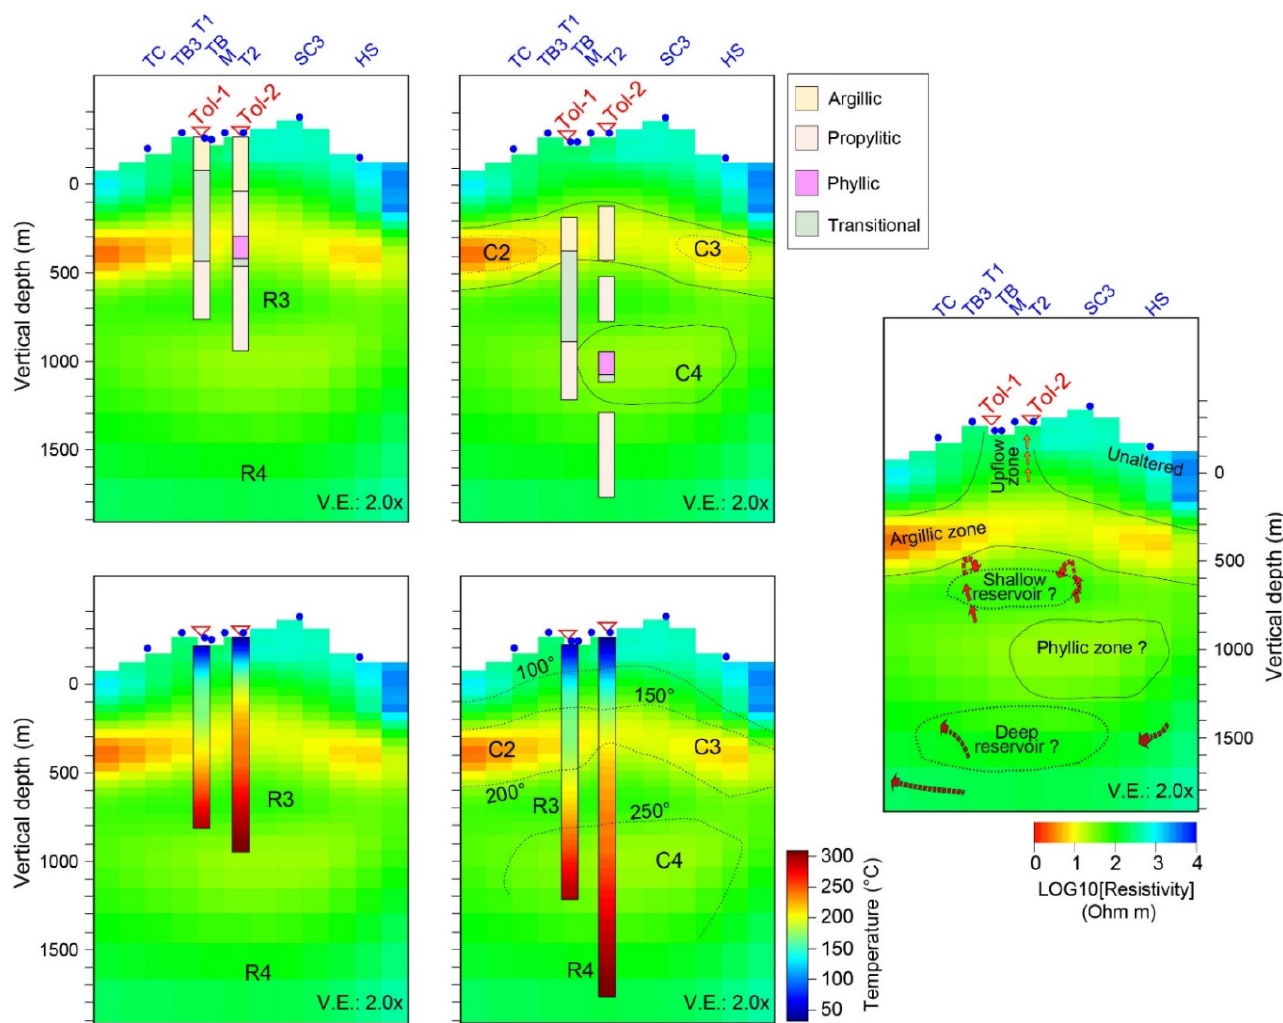
Figure 10. Detailed NS-slice through the central part of Tolhuaca geothermal system shown in Figure 9d, where the slim wells Tol-1 and Tol-2 are located. Blue circles indicate hot springs. Top left, NS-slice compared with hydrothermal alteration units from wells and correlated with conductivity anomalies. Bottom left, NS-slice compared with temperature logs and from hydrothermal alterations correlation. Middle right, schematic NS-slice interpretation showing conductive and intermediate resistivity anomalies related to the geothermal reservoir features. Note that the scale refers to the vertical extension of the wells.